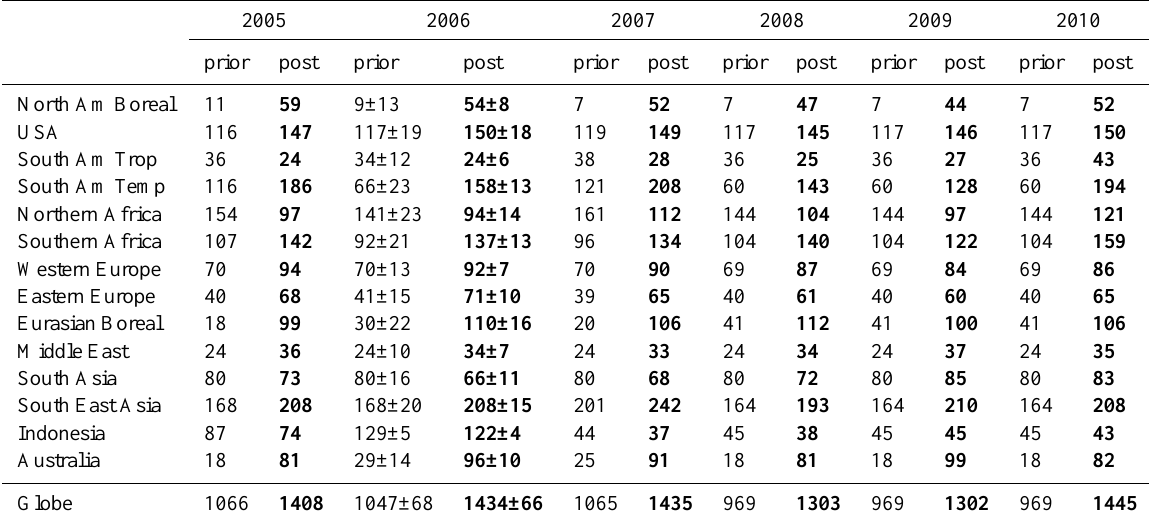
Table 2. Total CO emissions for years 2005 to 2010 before inversion and after inversion , for 14 continental regions and for the globe in TgCOyr − 1 . All budgets correspond to a 12-month period. The total estimates include an oceanic CO source amounting to 20TgCOyr − 1 . The uncertainty of the inverted fluxes for 2006 are computed by a Monte-Carlo